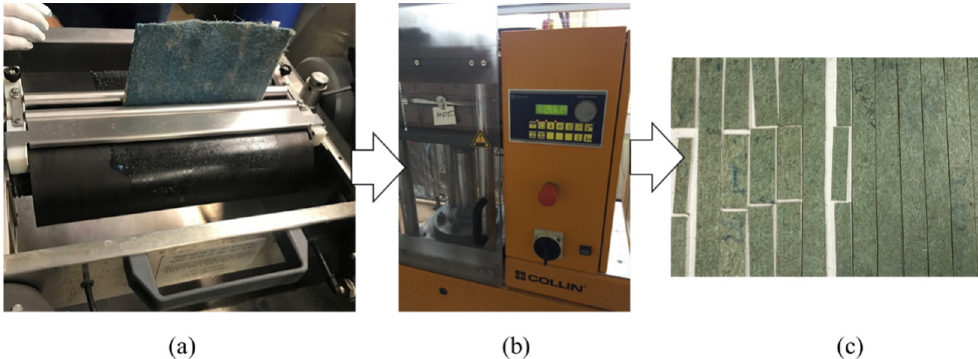
Figure 4. ( a ) Resin impregnation using foulard coating machine; ( b ) compression molding of prepregs; ( c ) test specimen cutting from cured laminates.